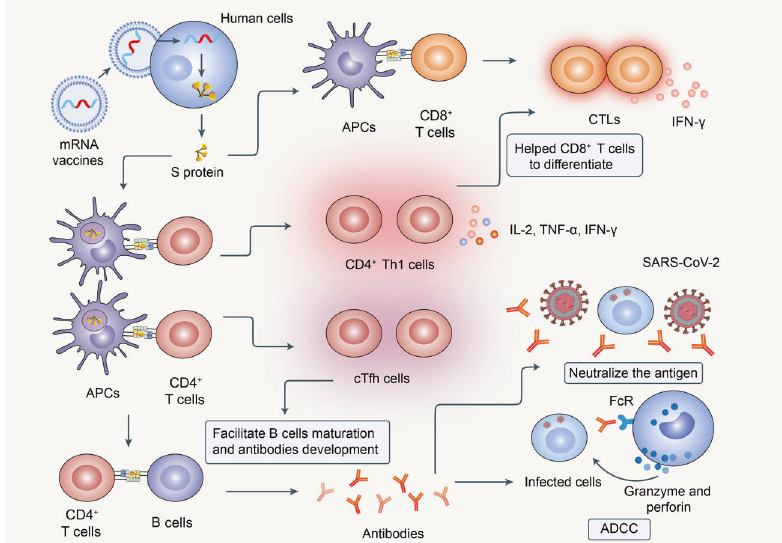
Fig. 3 The immune responses induced by mRNA vaccines. The mRNA vaccines encoding the S protein were inserted into human cells and recognized by antigen-presenting cells (APCs). They elicited robust CD8 + and Th1-type CD4 + T-cell responses. CD4 + Th1 cells promoted CD8 + T-cell expansion and differentiation through cytokine (e.g., interleukin [IL] − 2) production and expressed interferon (IFN)- γ , tumor necrosis factor (TNF)- α , and IL-2. CD8 + T cells also expressed IFN- γ . The circulating T follicular helper (cTfh) cells facilitated B-cell maturation and high- af fi nity antibody production. The vaccines also elicited robust immune responses and promoted antibody-dependent cellular cytotoxicity (ADCC)